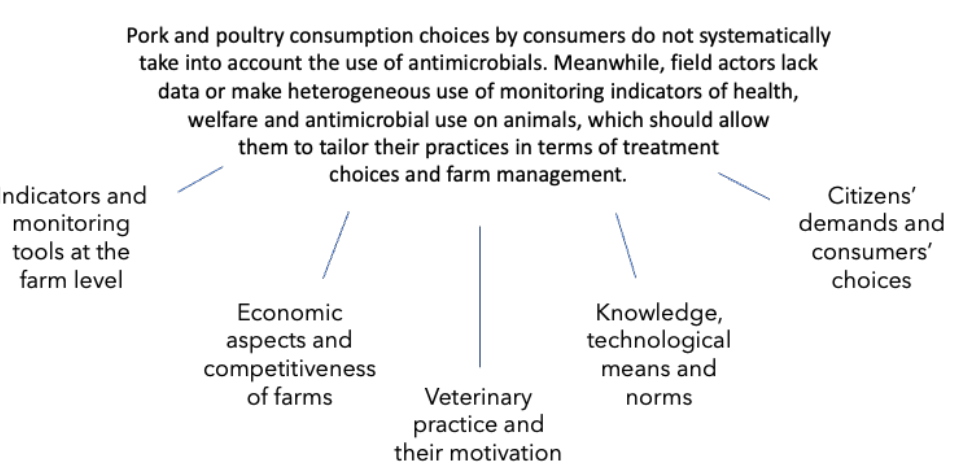
Figure 1. Problem tree displaying the five main categories of lock-in mechanisms that result in the central issue regarding the better use of antimicrobials and prevent the vision of the future from being reached, according to the participants. Table 1. Problems raised in the different branches of the problem tree (explanations)